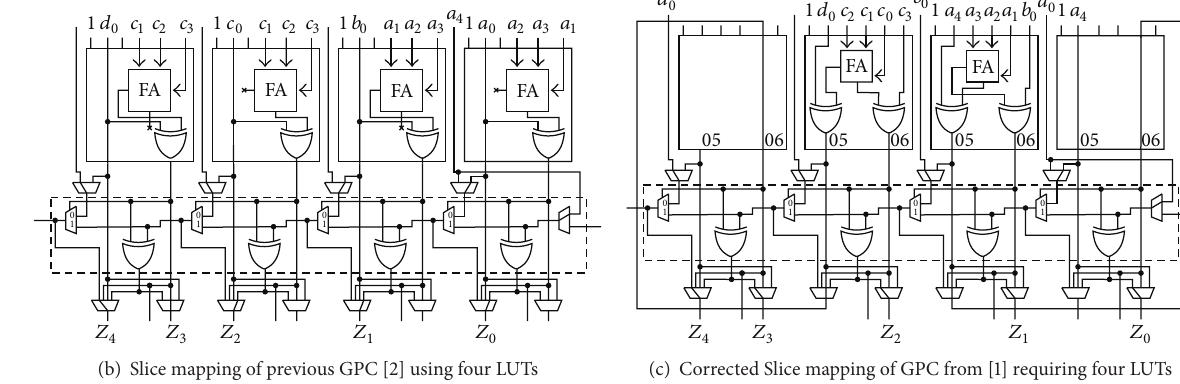
Figure 1: Mapping of (1,4,1,5;5) GPC to Xilinx Virtex